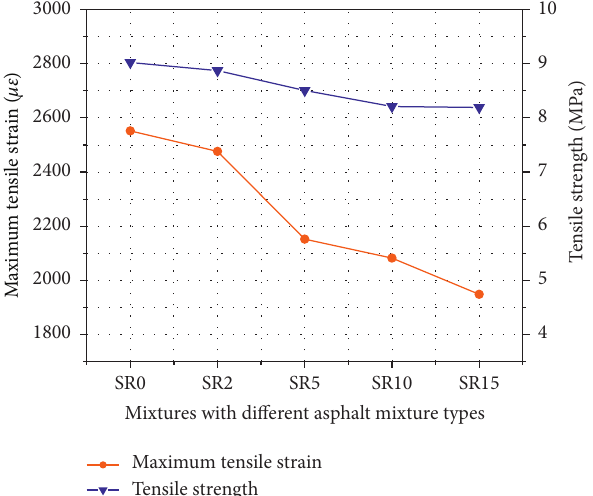
Figure 11: Maximum tensile strain and tensile strength of different asphalt mixtures.